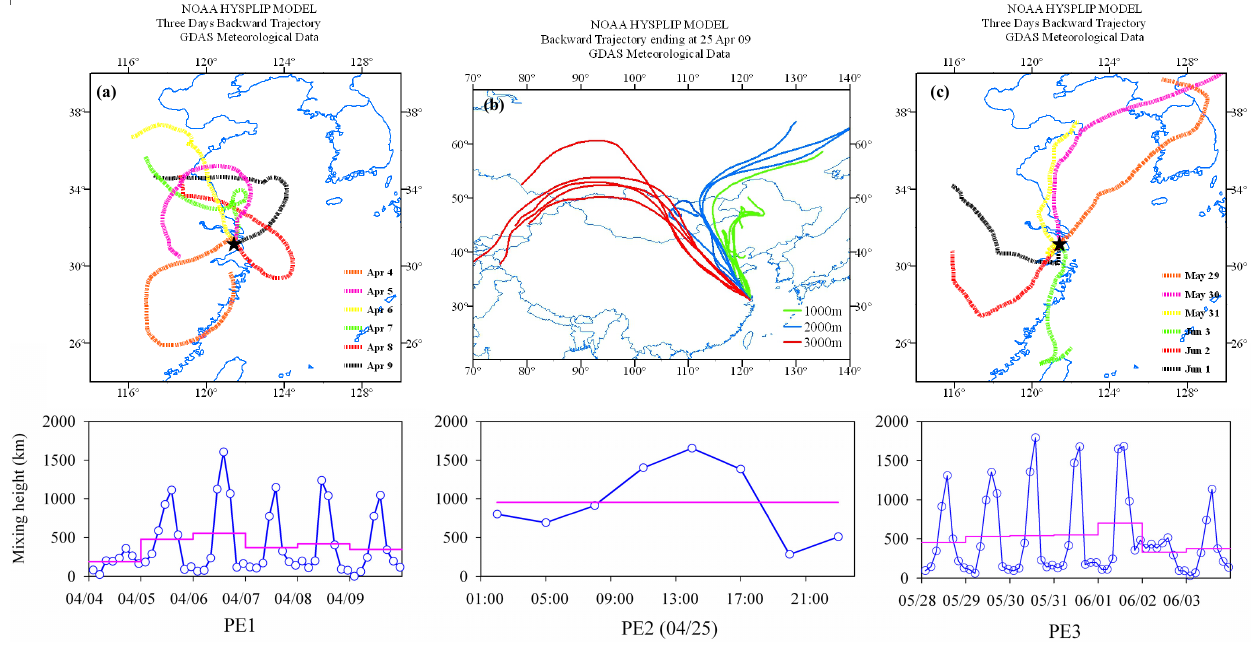
Fig. 3. Three days air mass backward trajectory at Shanghai computed by the NOAA Hybrid Single-Particle Lagrangian Trajectory (HYS- PLIT) model during (a) PE1, (b) PE2, and (c) PE3, respectively. The starting altitude during PE1 and PE3 was 500m and three altitudes of 500, 1000 and 1500m were computed during PE2. The mixing heights during the three episodes were computed using the NCEP Global Data Assimilation System (GDAS) model (http://ready.arl.noaa.gov/READYamet.php) and shown below the trajectory panel (blue dots denoted the 3h average mixing height and the pink horizontal step lines denoted the daily average mixing